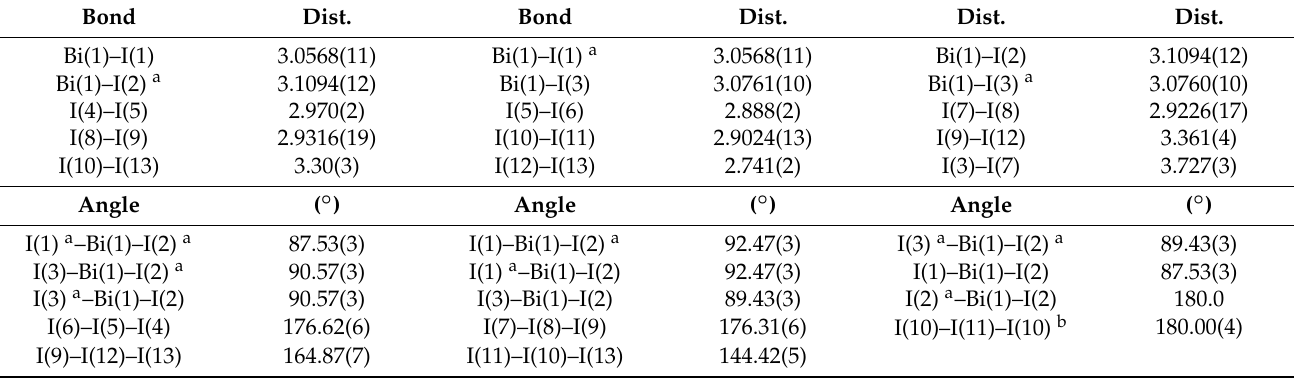
Figure 2. Quasi-3-D network of 1 based on I···I contacts and hydrogen bonds. Table 1. Selected Bond Lengths (Å ) and Bond Angles (°). Table 2. Hydrogen Bond Lengths (Å) and Bond Angles ( ◦